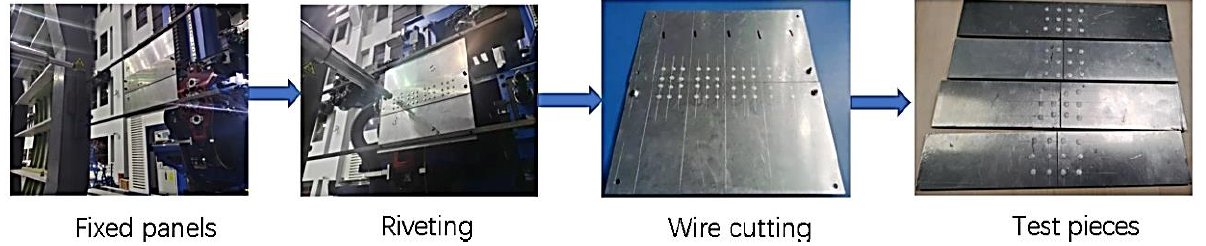
Figure 16. Preparation process of test pieces.